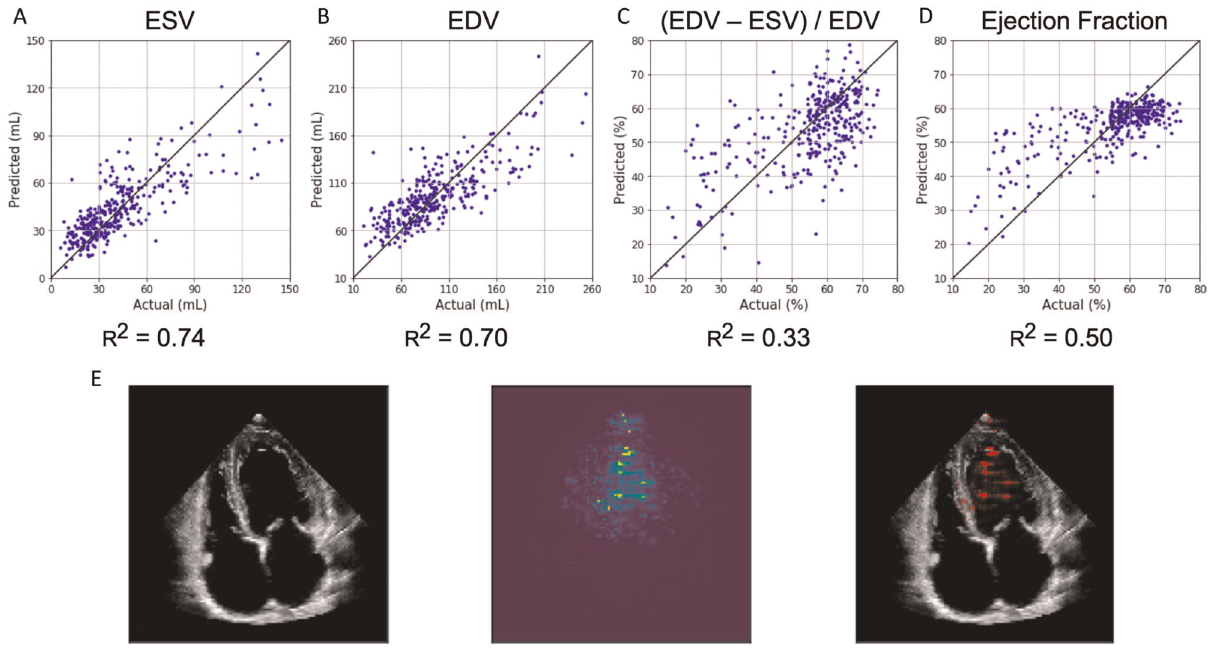
Fig. 3 EchoNet performance and interpretation for ventricular size and function. EchoNet performance for a predicted left ventricular end systolic volume, b predicted end diastolic volume, c calculated ejection fraction from predicted ESV and EDV, and d predicted ejection fraction. e Input image, interpretation, and overlap for ejection fraction